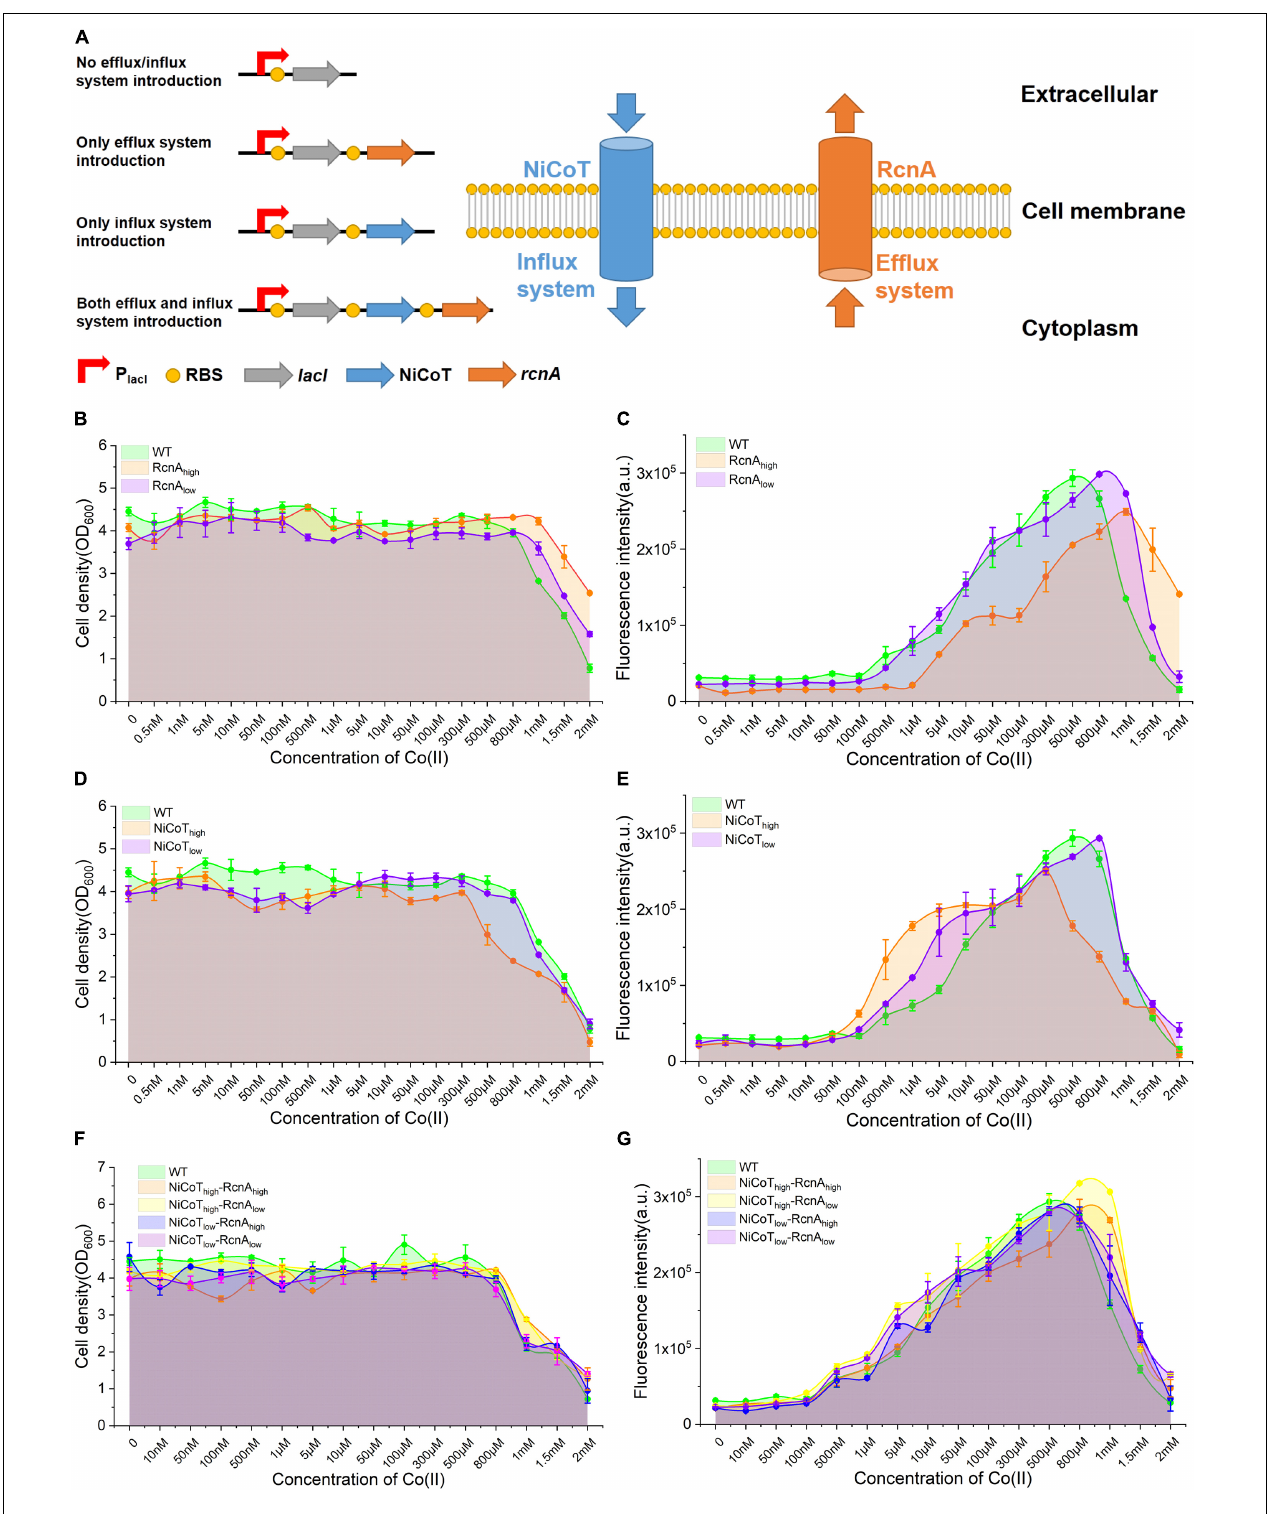
FIGURE 3 | Characterization of the performance of CIES under synthetic cobalt homeostasis system. (A) Schematic diagram of synthetic cobalt homeostasis system by introducing the cobalt influx system (NiCoT) and/or efflux system (RcnA). (B,C) The influence of efflux system introduction on the cell growth and GFP expression of CIES at different concentrations of Co(II). (D,E) The influence of influx system introduction on the cell growth and GFP expression of CIES at different concentrations of Co(II). (F,G) The influence of both influx system and efflux system introduction on the cell growth and GFP expression of CIES at different concentrations of Co(II). All error bars in figures presented root-mean-square deviation of three separate experiments.